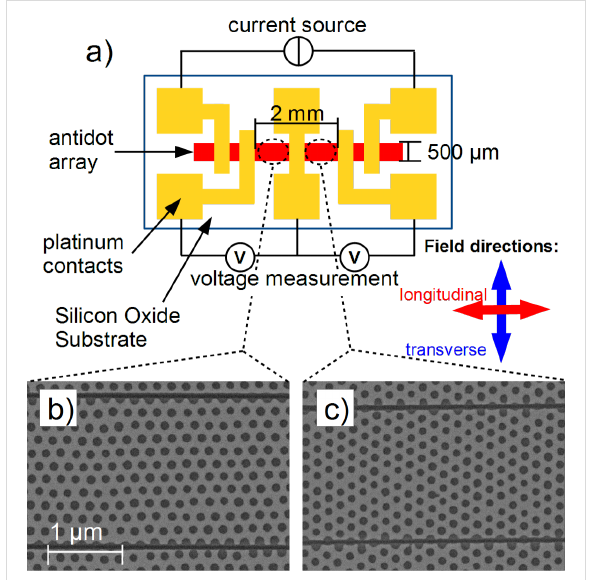
Figure 7: (a) Schematics of the sample geometry for AMR measure- ments. The red and blue arrows indicate the direction of the magnetic field for longitudinal and transverse geometries, respectively. SEM images show antidot arrays with FIB-milled cuts (dark lines) along the nearest neighbour (b) and along the next nearest neighbour direction (c). Reproduced with permission from [29], copyright 2013 IOP Publishing